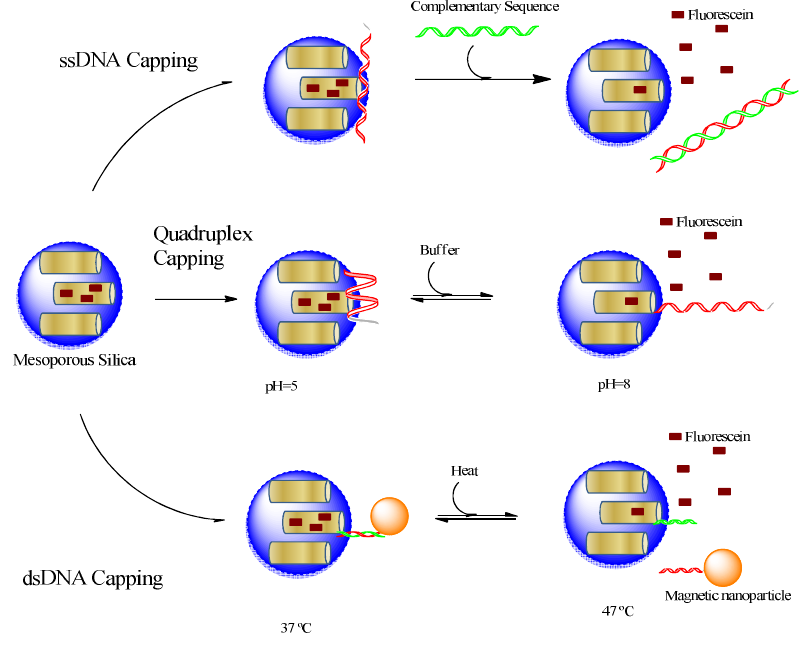
Figure 3. DNA oligonucleotide capping mechanisms; single stranded, quadruplex or double stranded DNA were used to cap mesoporous silica